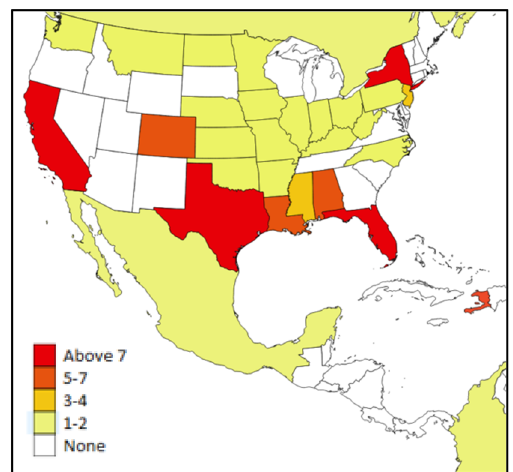
Fig. 1 Number of studies by location